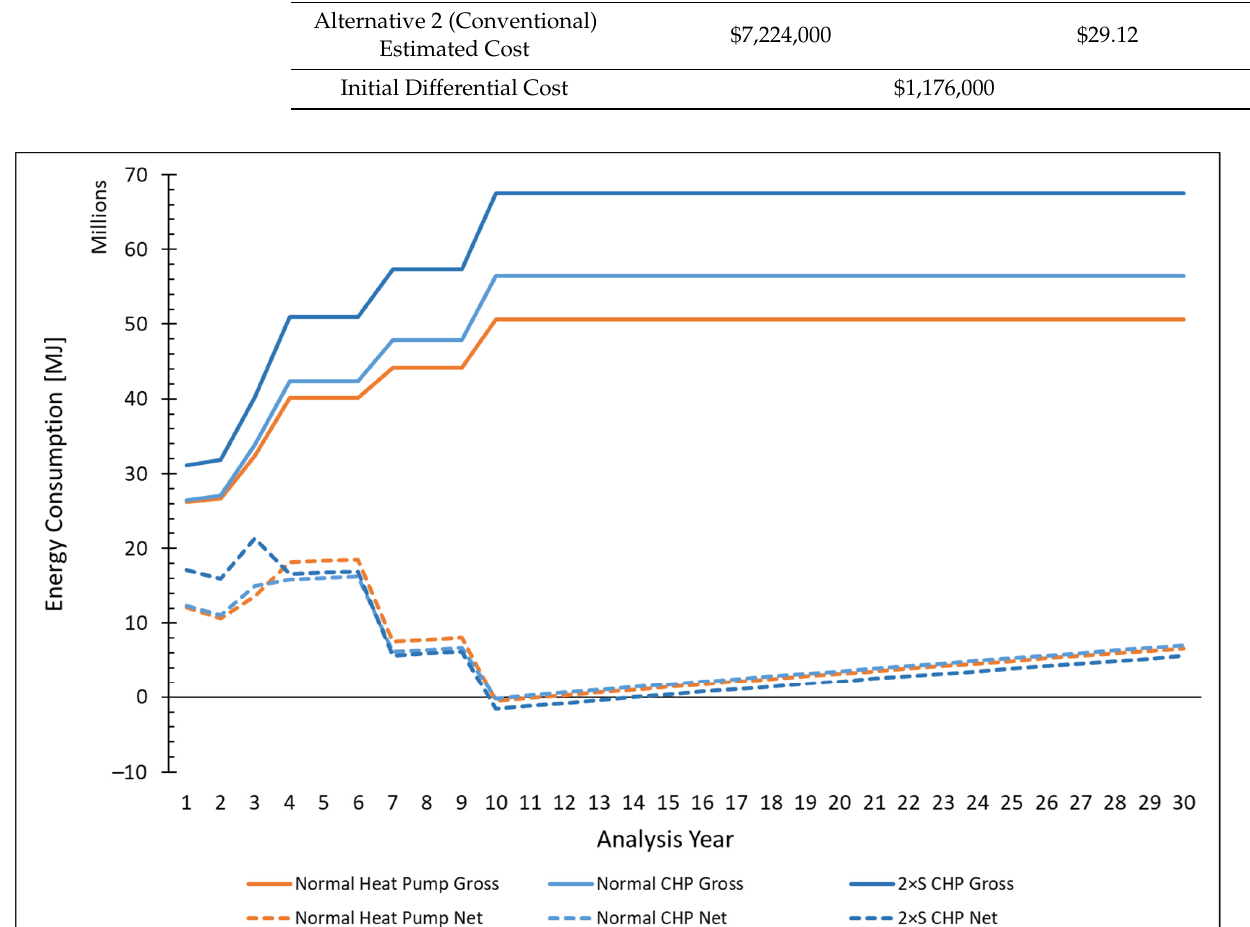
Table A6. Summary Construction Cost Comparison table for Ground Source Heat Pump study of CSU’s Moby Arena used to determine a cost premium metric ($/kW) for installation of a heat pump system relative to a conventional heating and cooling system.